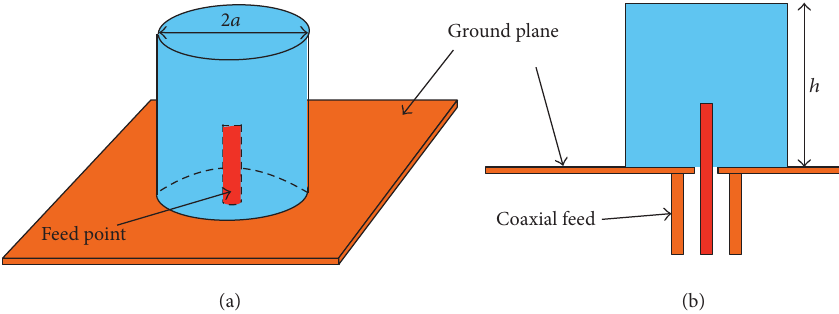
Figure 2: Three-dimensional (a) and cross-sectional view (b) of the probe-fed cylindrical DRA.